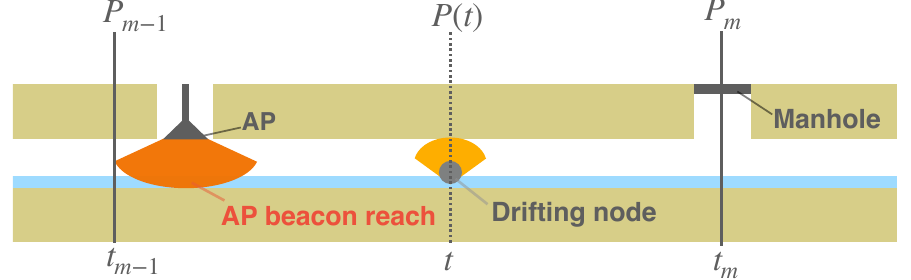
Figure 5. Landmarks (AP and utility holes) and a CN drifting between